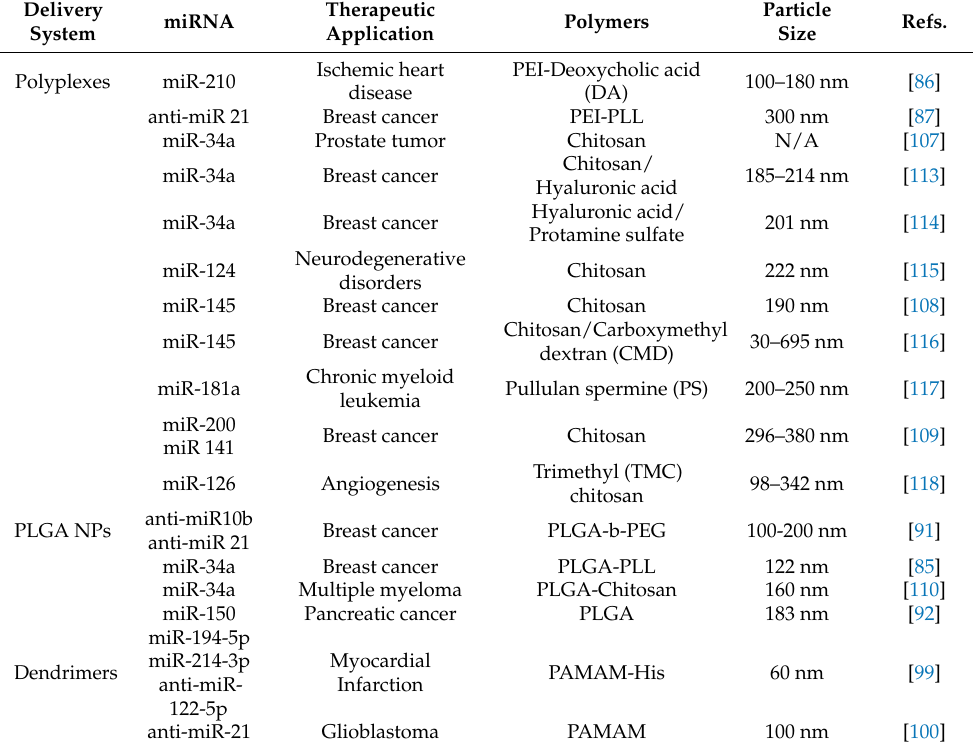
Table 3. Polymeric-based miRNA delivery